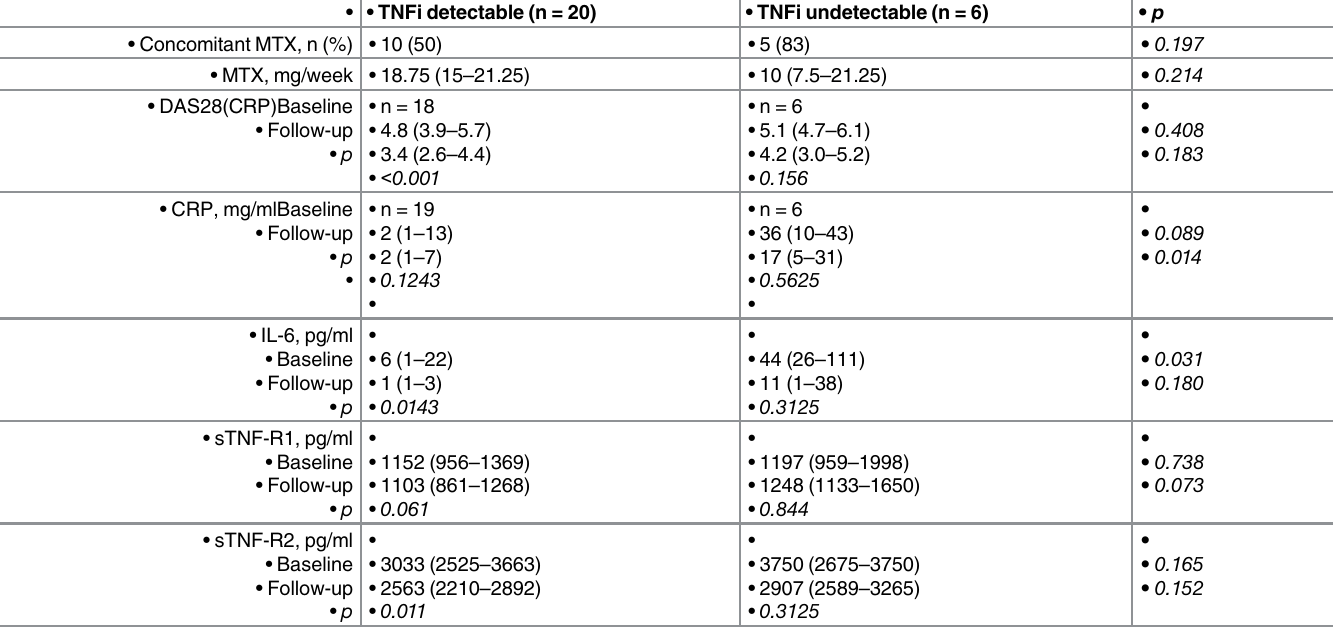
Table 2. Clinical variables and biomarkers according to whether TNFi was detectable in the patients ’ blood following 6 months of treatment with adalimumab or infliximab.